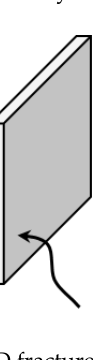
Figure A1. The 3D fracture volume is equal to the 2D fracture surface.